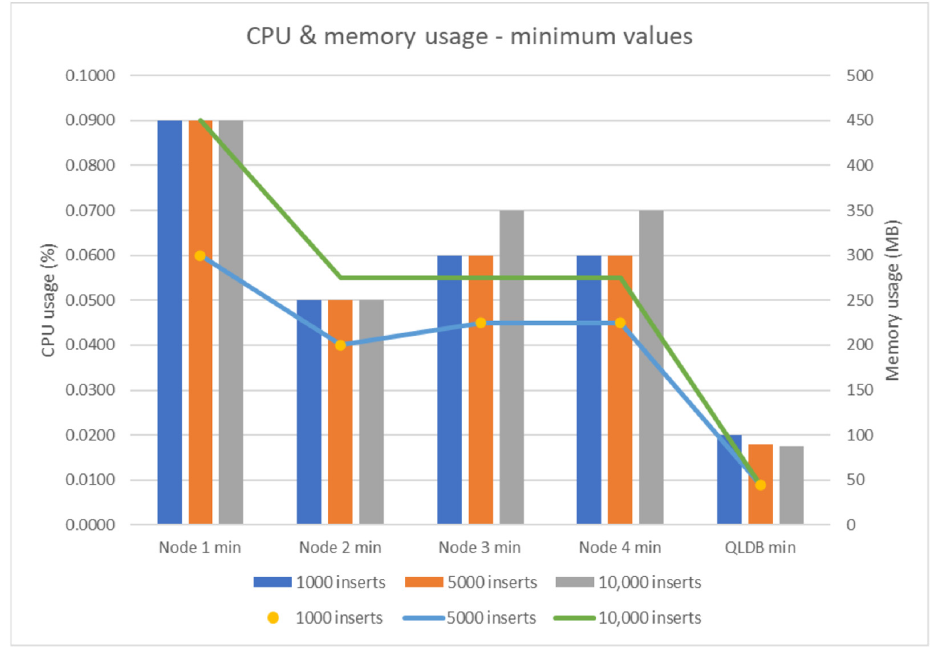
Figure 32. CPU and memory usage—minimum values.